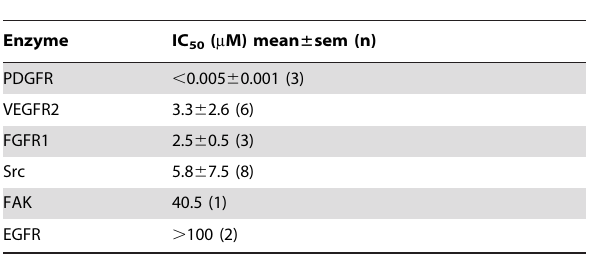
Table 1. SU9518 selectively inhibits PDGFR.